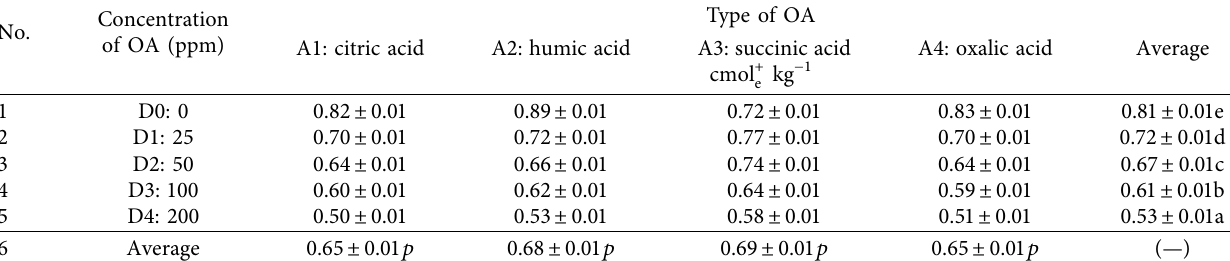
Table 6: Efect of OAs application on phosphate rock to Al 3+ average from 4 observation times. No.